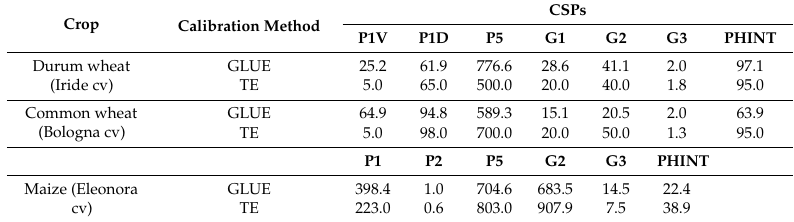
Table 7. CSPs of durum wheat, common wheat, and maize obtained with TE and GLUE methods.